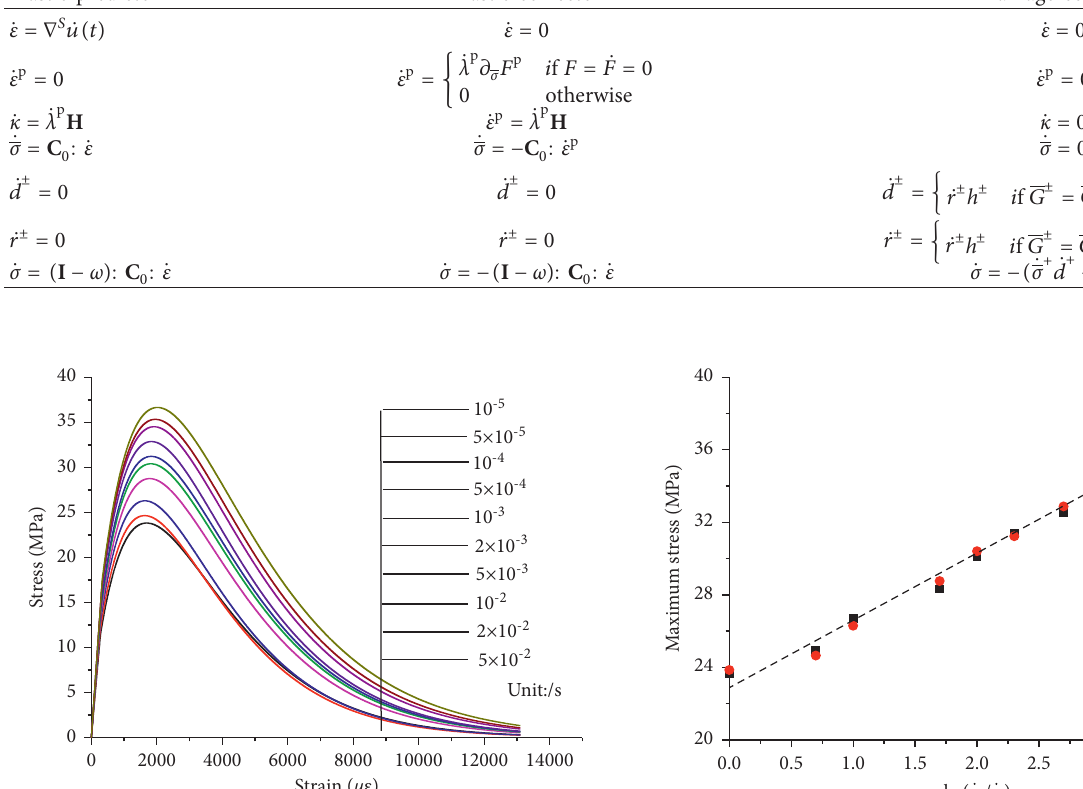
Table 7: Numerical implementation of the dynamic plastic damage model based on the return-mapping algorithm. Elastic-predictor